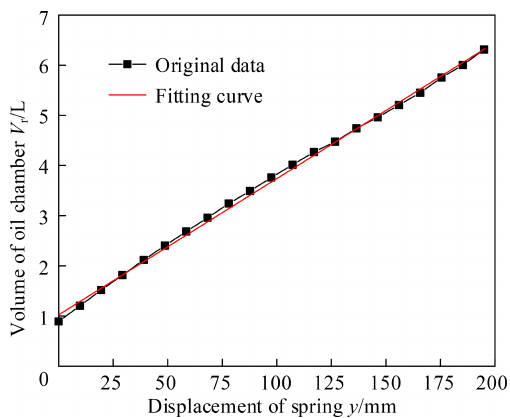
Figure 7. The volume of the oil chamber variation with the spring displacement.